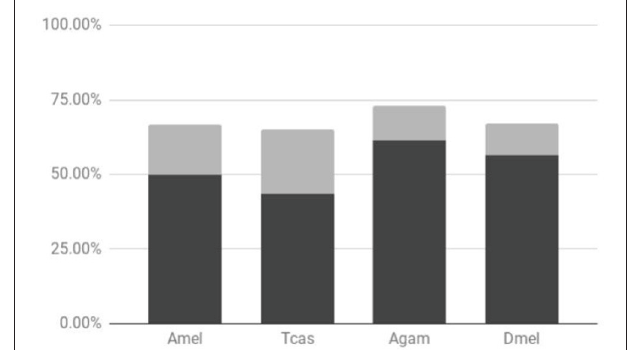
FIGURE 1 | Bar chart comparison of lineage-specific developmental gene duplicate numbers. Y-axis represents absolute numbers of gene families in Drosophila melanogaster (Dmel), Anopheles gambiae (Agam), Tribolium castaneum (Tcas), Apis mellifera (Amel), and Acyrthosiphon pisum (Aphis). Bar areas with black, dark gray, and light gray shading represent gene families with two, three and four or more lineage-specific duplications, respectively.